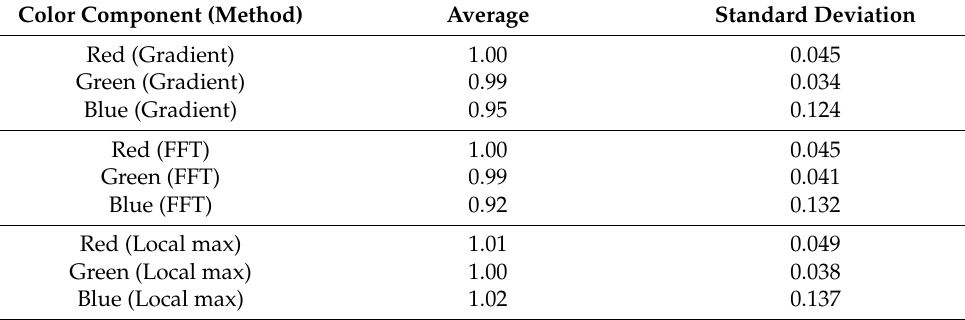
Table 2. Statistical data for 30-s video